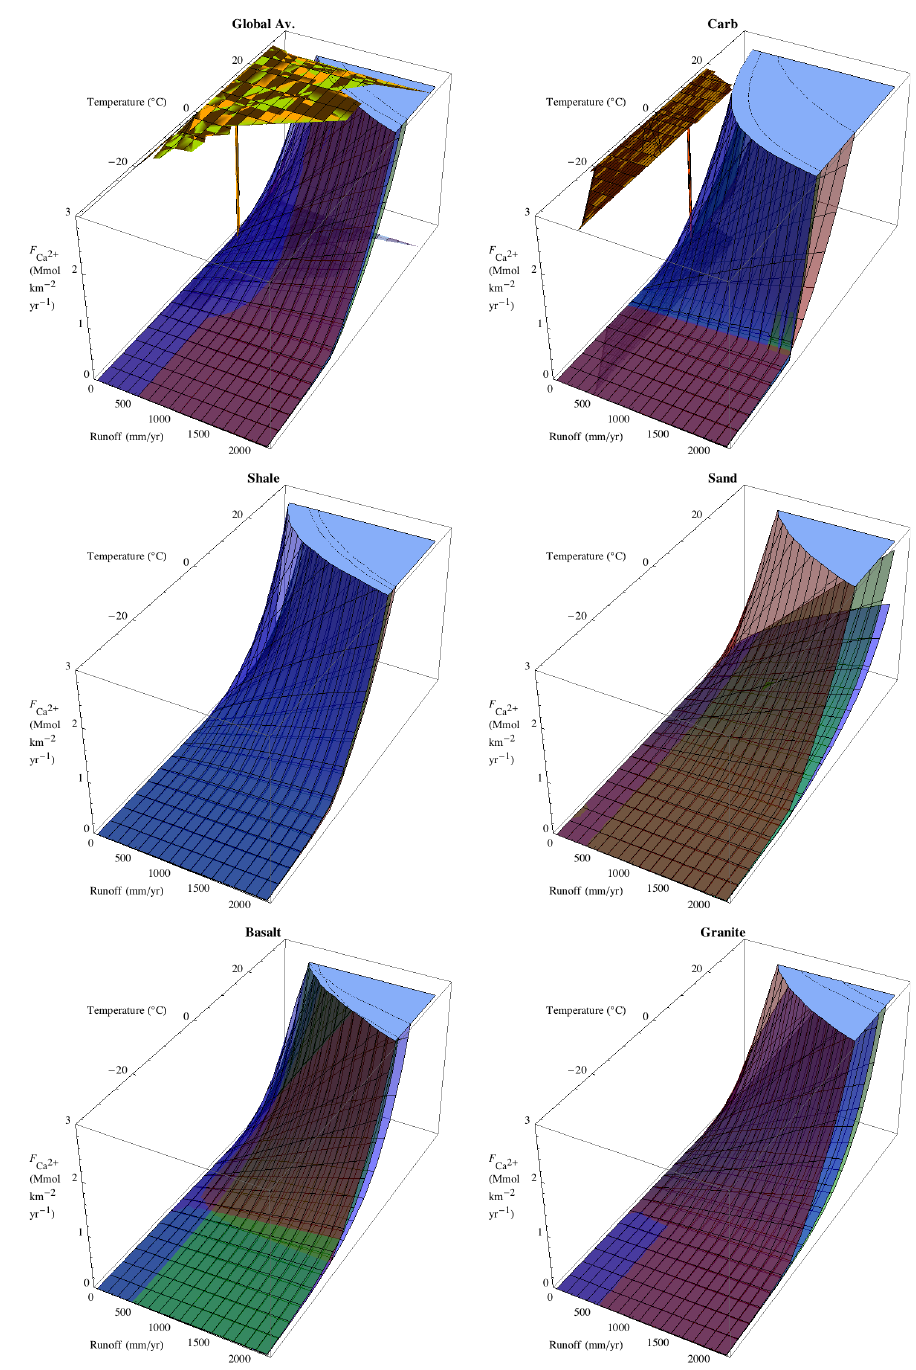
Fig. 18. Weathering flux (Ca 2 + ) vs. temperature and run-off for different rock types and weathering schemes (Blue – GKWM, Green – GEM-CO2, Red – Globavg). “Global Av.” means the weighted global average lithology, corresponding to 12.1% carbonate, 23.0% shale, 23.8% sandstone, 4.6% basalt, 24.9% shield, 2.0% acid volcanic and 9.7% ice cover. Overlayed on the Global Av. and Carb plots are temperature and run-off observational data (yellow; New et al. (1999); Fekete et al. (2002)) and model output (orange) from GENIE at a steady pre-industrial state after a spin-up (Sect. 2.4); global average values are shown as the vertical lines (note that the mottled textures are a plotting artefact). 71